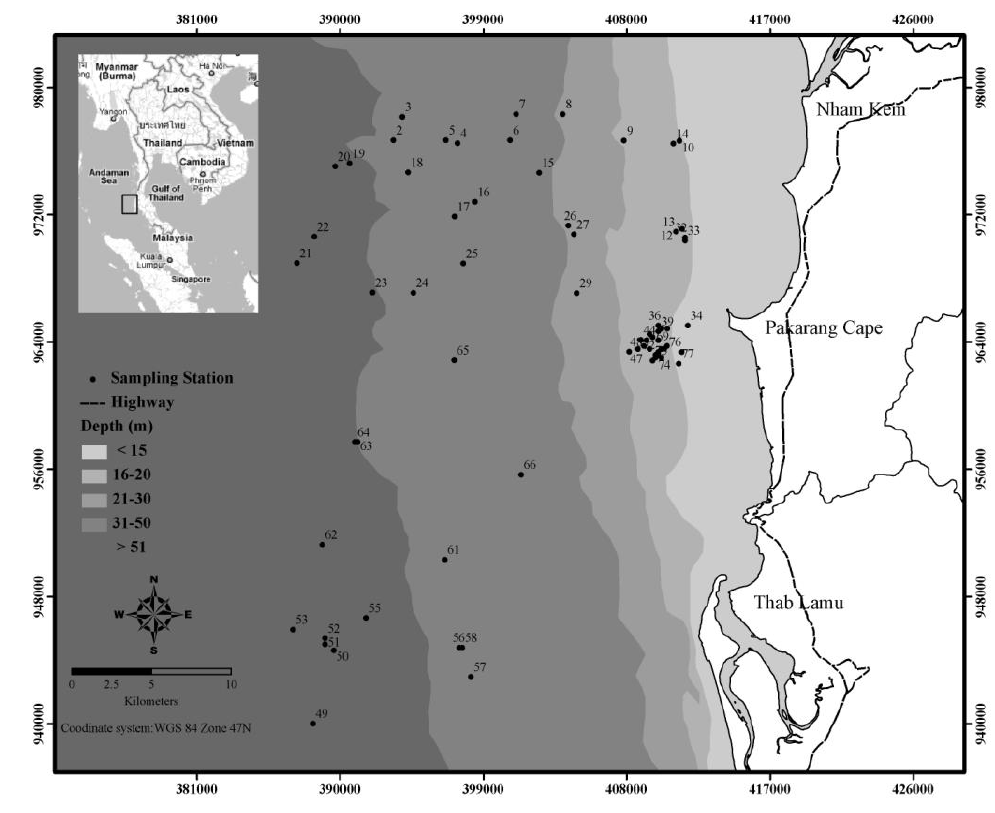
Fig. 1. Sampling site locations at Khao Lak coastal areas, Phang Nga Province, Thailand. (The study area is indicated by the black box; Figure 1. Sampling site locations at Khao Lak coastal areas, Phang Nga Province, 2 numbers indicate sampling stations; the color contours represent the water Thailand. (The study area is indicated by the black box; Numbers indicate sampling 3 stations; the color contours represent the water depth) 4